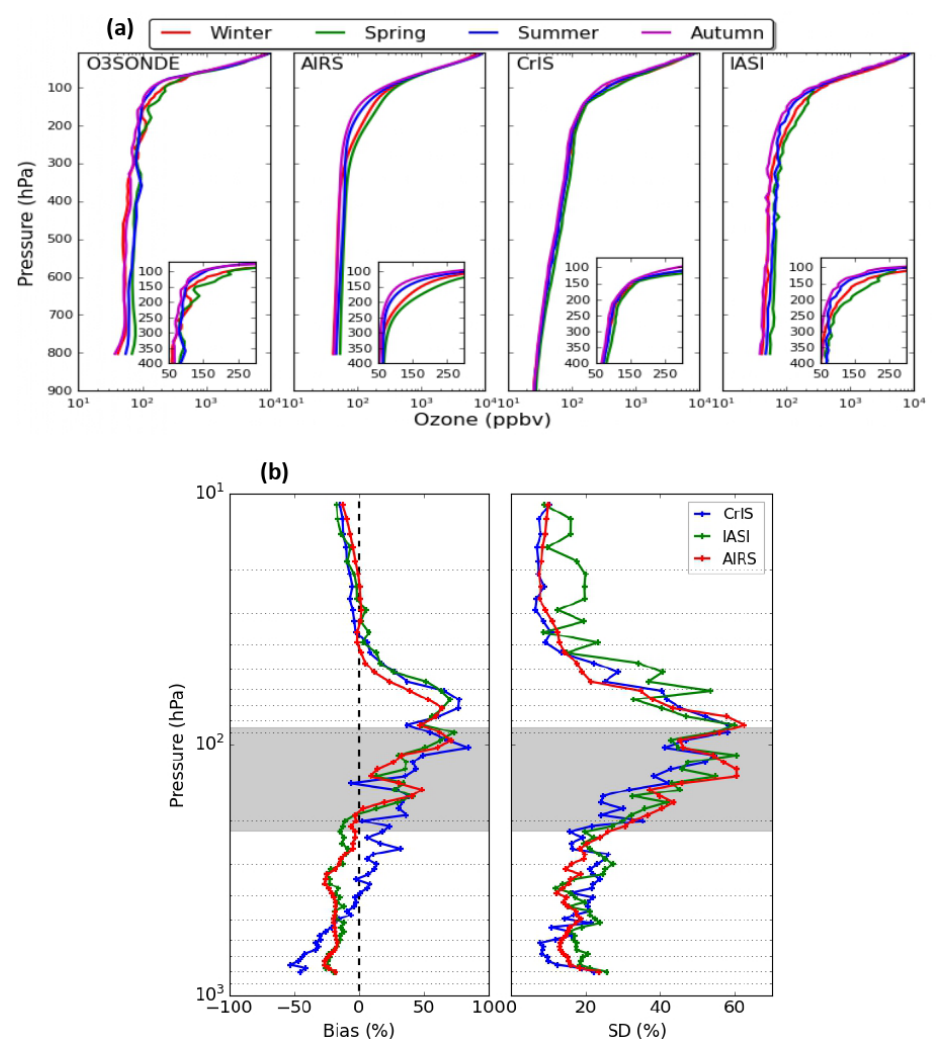
Figure 8. (a) Seasonal ozone profiles of three IR satellites (IASI, AIRS, and CrIS) for a smaller sample size (April 2014 to April 2015). The IASI and CrIS products are generated using the AIRS heritage algorithm (NOAA), and only zero quality control flags (QC = 0) of retrievals are used. (b) Statistical error analysis for the ozone retrieved by three IR satellites without applying the averaging kernel information. The grey shaded area shows the tropopause region from balloon-borne